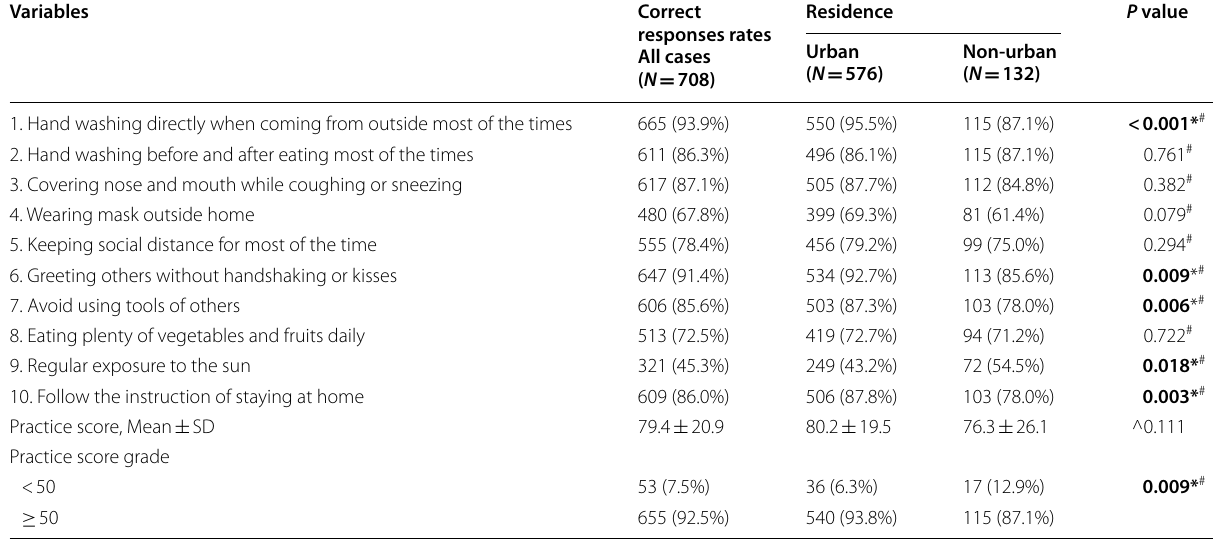
Bold values indicate significance of the data Data presented as frequency (percent) unless mentioned otherwise # Chi square test § Fishers Exact